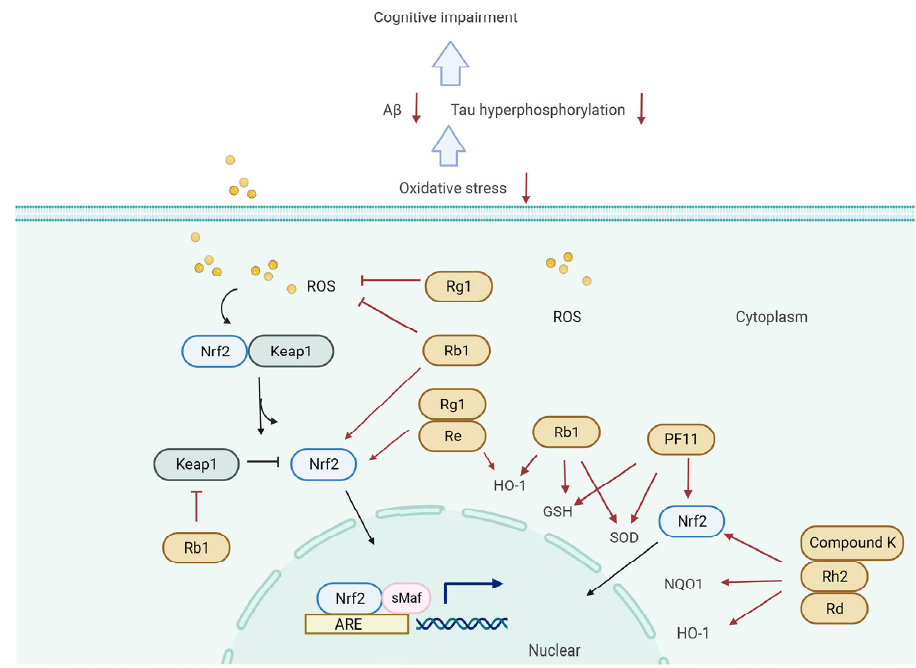
Figure 5. Molecular mechanisms of regulating Keap1/Nrf2 signaling pathway by ginsenosides in treating cognitive impairment in the pathological model. ( 1 ) Rg1 and Rb1 directly reduce the content